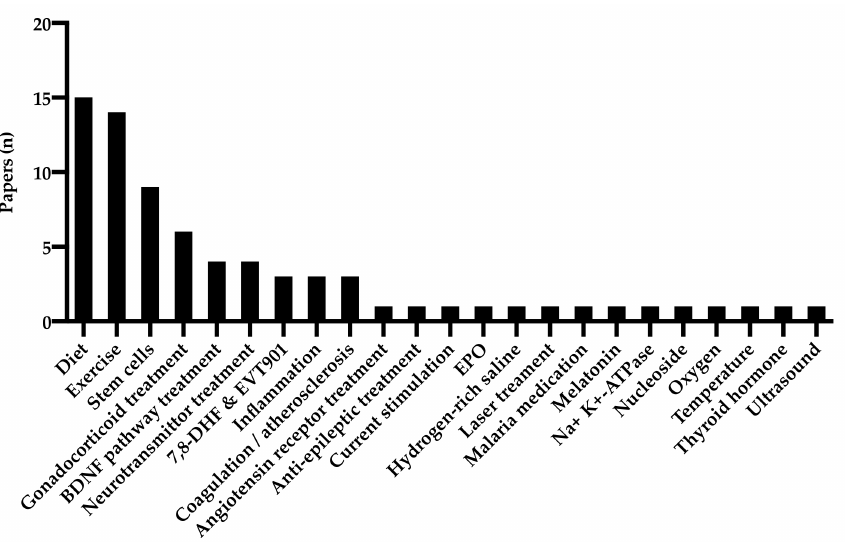
Figure 5. Treatment groups of the reviewed